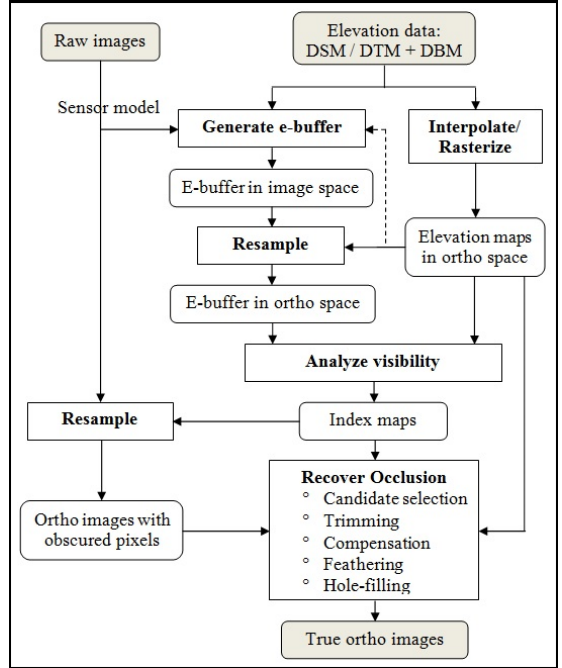
Figure 1. The overall workflow for true ortho generation